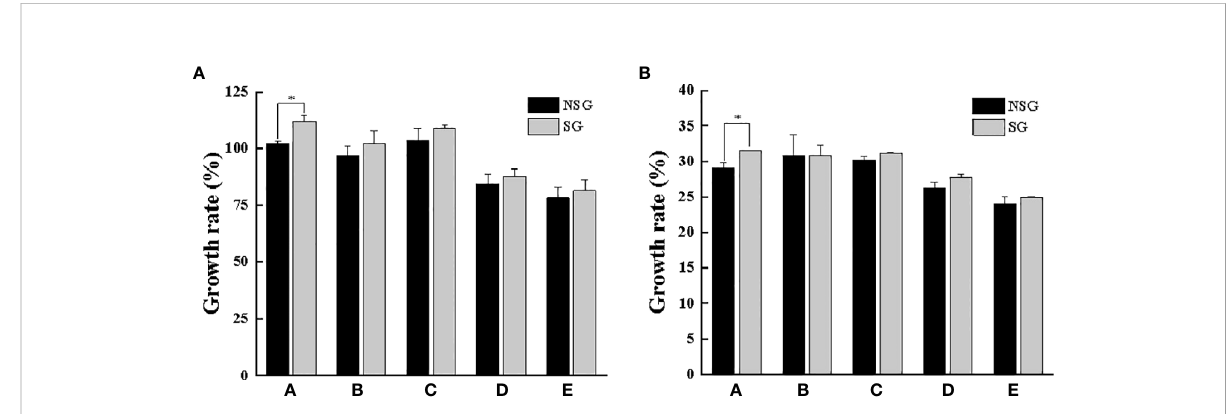
FIGURE 9 Growth rate of body weight (A) and carapace width (B) of swimming crab with different body weight between NSG and SG. “ * ” indicates signi fi cant differences ( P <